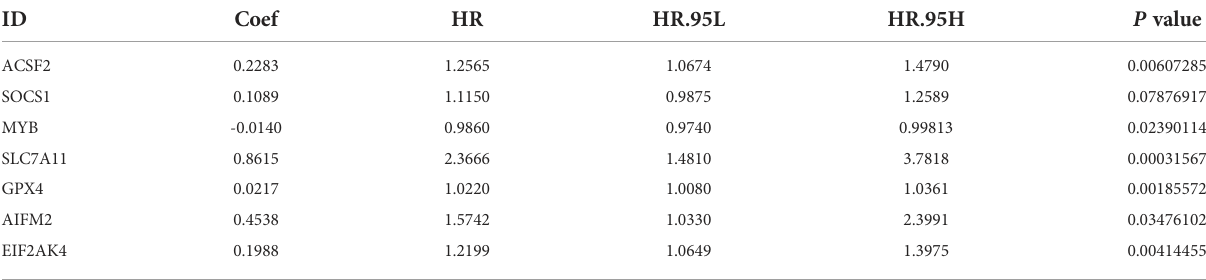
TABLE 2 Seven ferroptosis-related messenger RNAs(mRNAs) detected using multivariable Cox regression analysis. ID Coef HR ACSF2